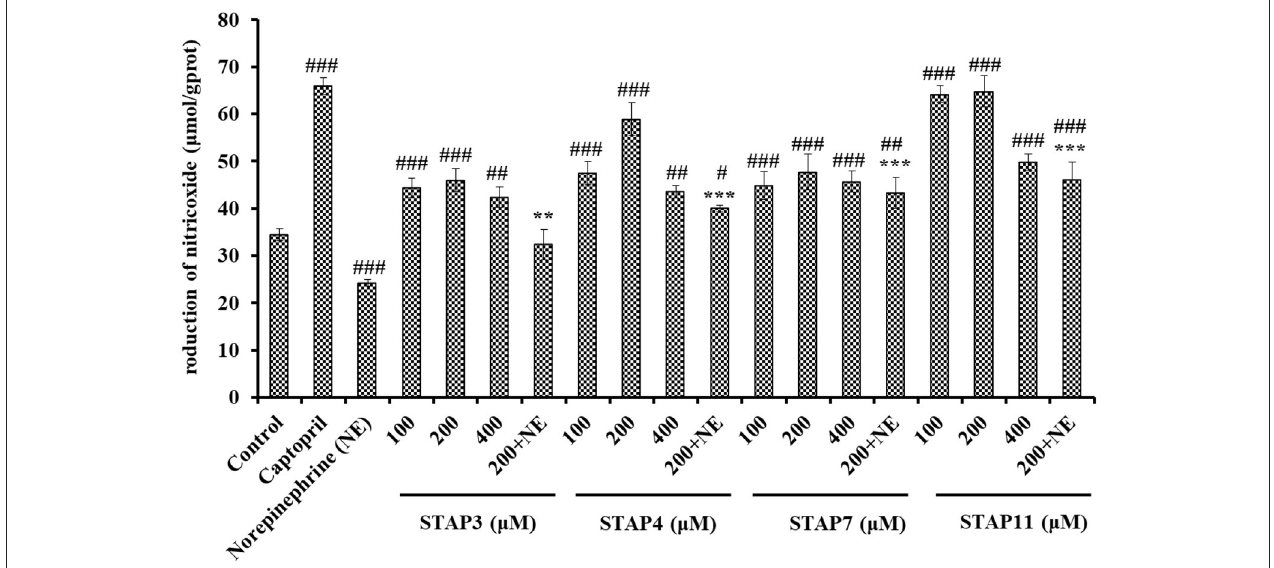
FIGURE 7 | The production of nitric oxide (NO) of HUVECs treated with STAP3, STAP4, STAP7, and STAP11 for 24h, respectively. Cell group treated with captopril (Cap) was designed as a positive control. ### P < 0.001, ## P < 0.01, and # P < 0.05 vs. control group; *** P < 0.001 and ** P < 0.01 vs. norepinephrine (NE)